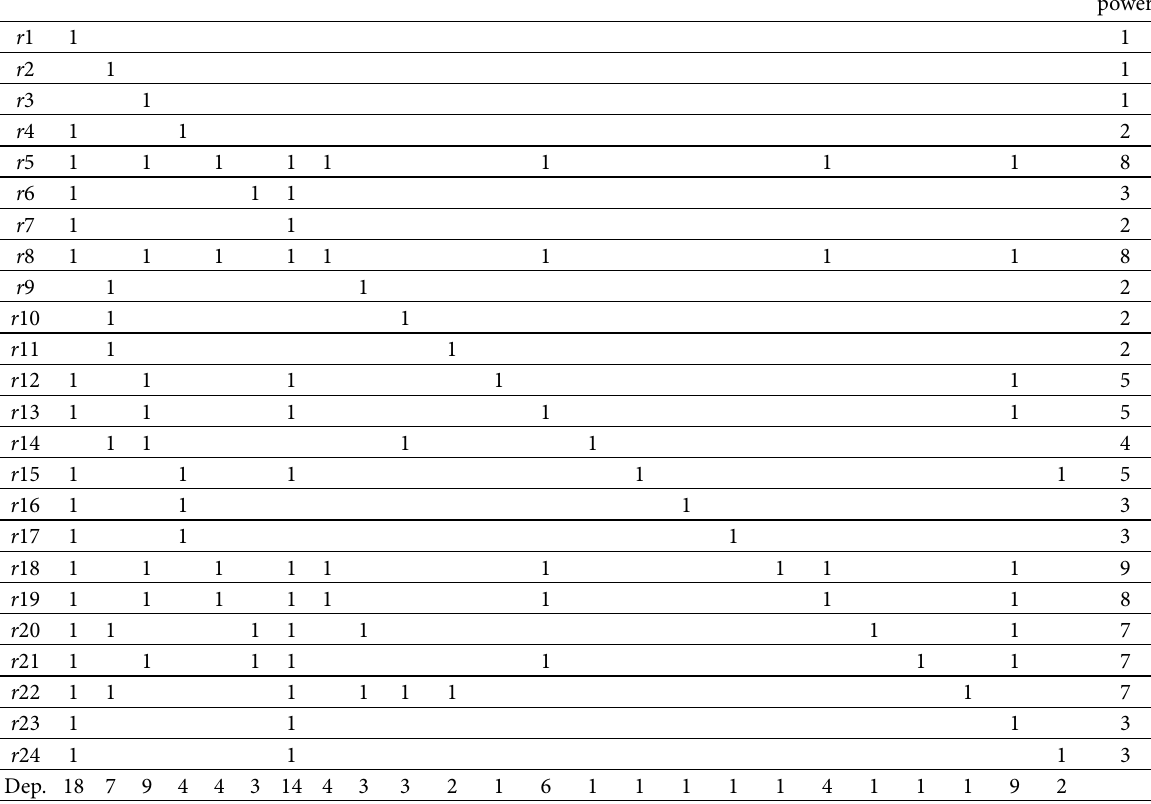
Table 3. The final reachability